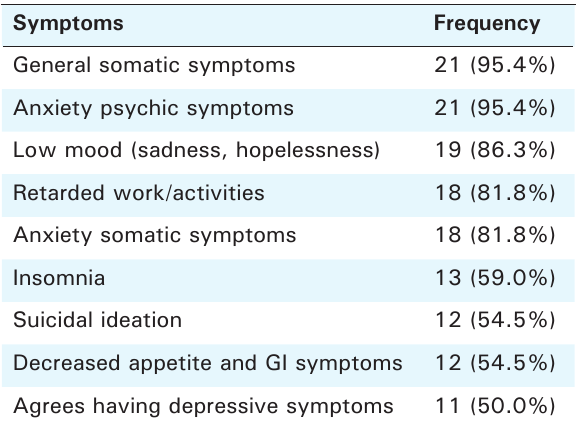
Table 3. Distribution of symptoms in antenatal depression (n=22)